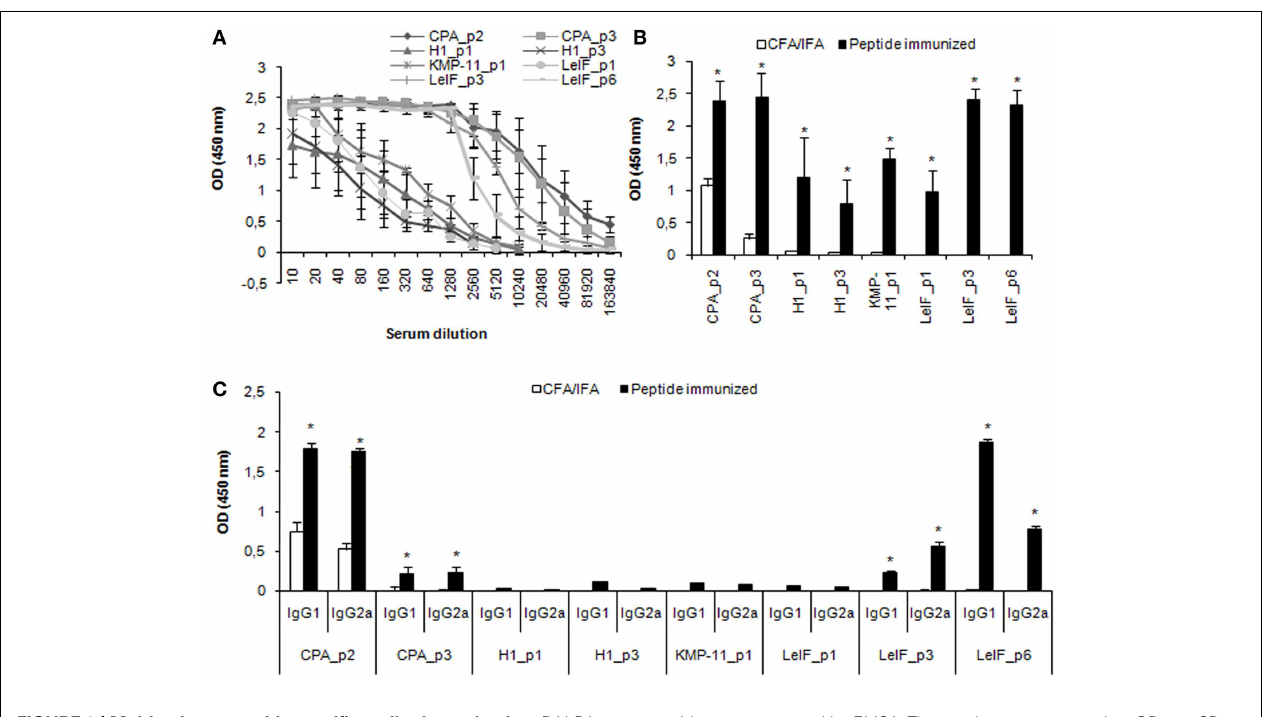
FIGURE 3 | Multi-epitope peptide-specific antibody production . BALB/c mice ( n = 9/group) immunized either with individual peptide emulsified in CFA/IFA or PBS alone, were bled 15days post third immunization and sera were separated. (A,B) total IgG Abs, and (C) IgG1 and IgG2a Abs against each